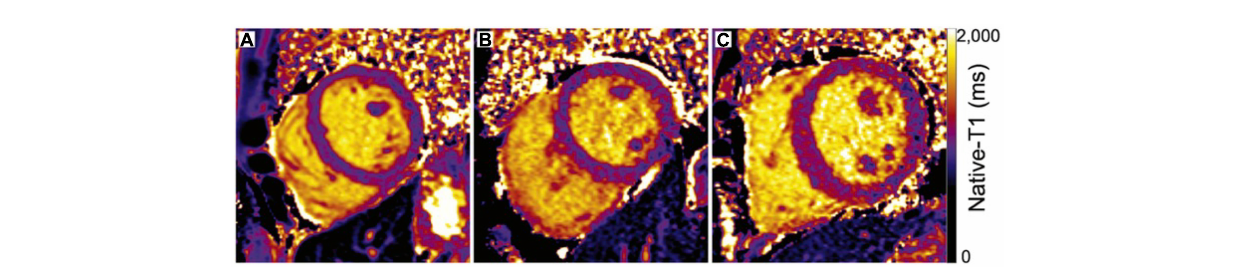
FIGURE3 Maps of native-T1 relaxation times in (A) a healthy control and (B) a diabetic adult with normal left ventricular structural parameters demonstrate similar global mean T1 relaxation times ( A : 1014 ms, B : 1023 ms). (C) In contrast, elevated native-T1 relaxation times within the septum, anterior wall, and inferior right ventricular insertion area of a diabetic adult with increased septal wall thickness (1.4 cm) and elevated mass-to-volume ratio (1.4 mg/ml) result in a longer mean left ventricular native-T1 time ( C : 1,095 ms) compared to either A or B . Adapted from Lam et al. with permission